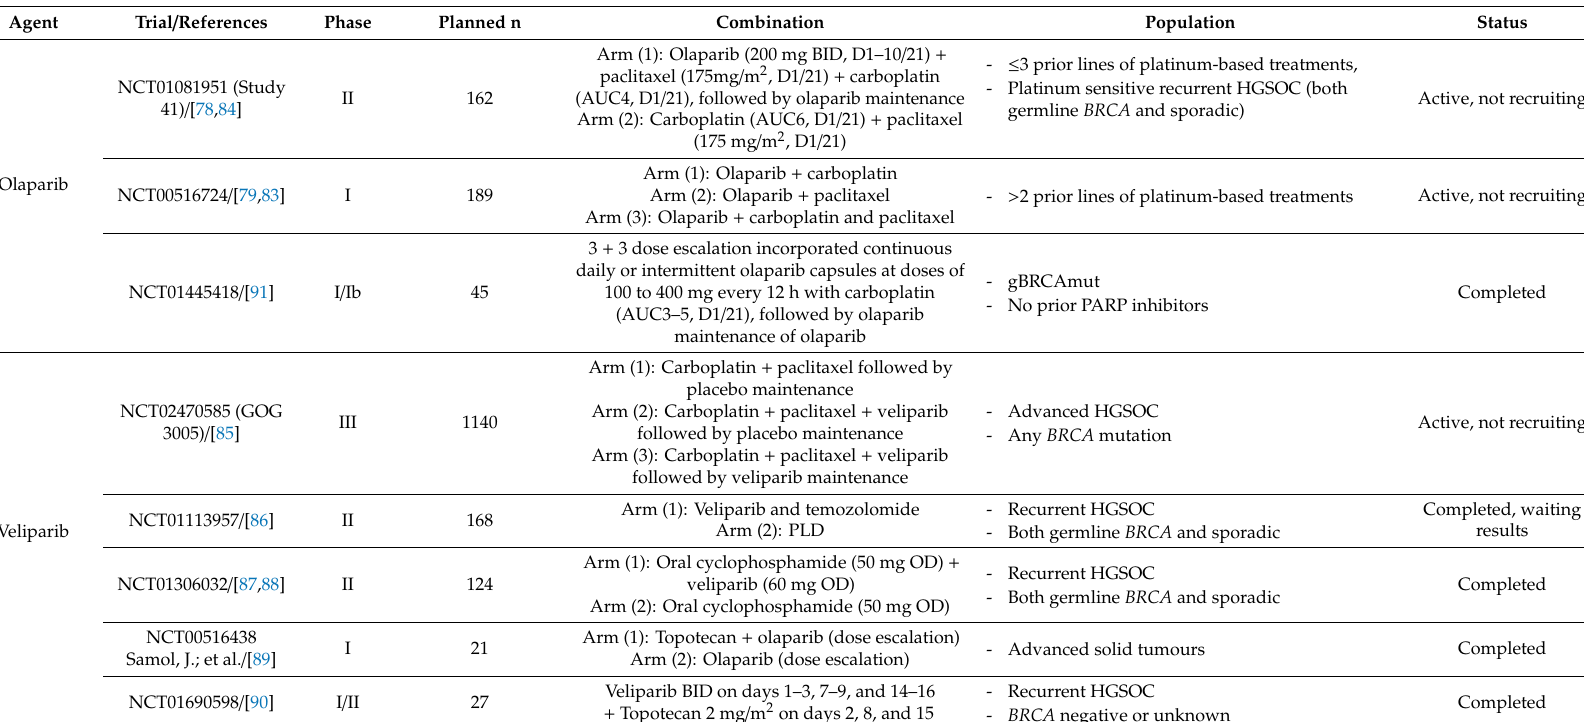
Table 4. Ongoing combination trials with PARP inhibitors and chemotherapy